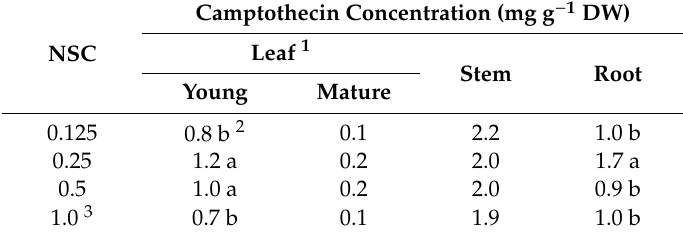
Table 2. E ff ects of nutrient solution concentration (NSC) on camptothecin concentration of O. pumila organs at 63 days after the start of the treatment (DAT) in experiment 1 ( n = 8).